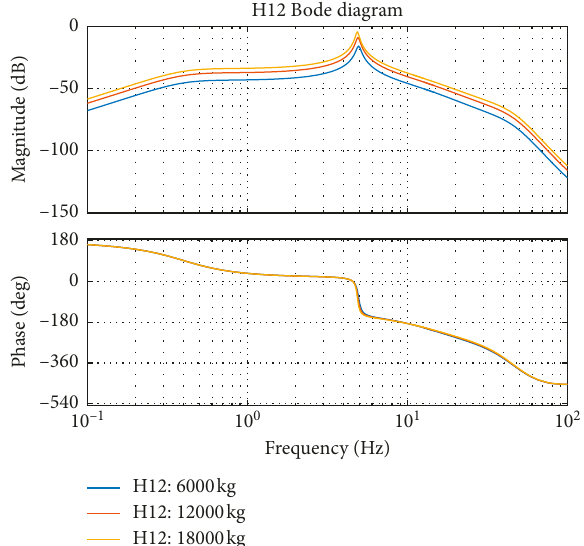
12 . Figure 5: Effect of specimen’s natural frequency on frequency response of H 11 .